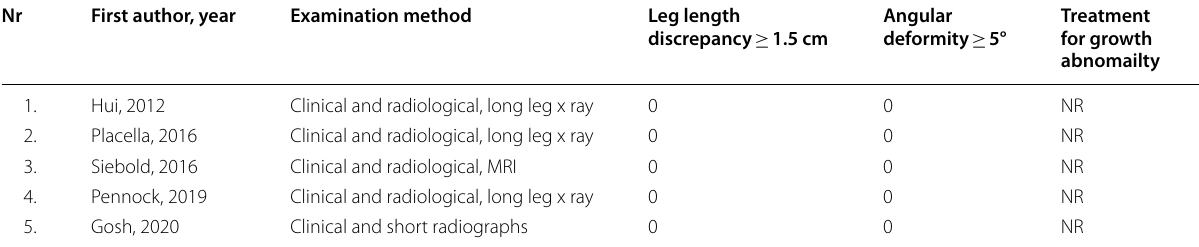
Table 5 Leg length discrepancies in studies using independent femoral drilling